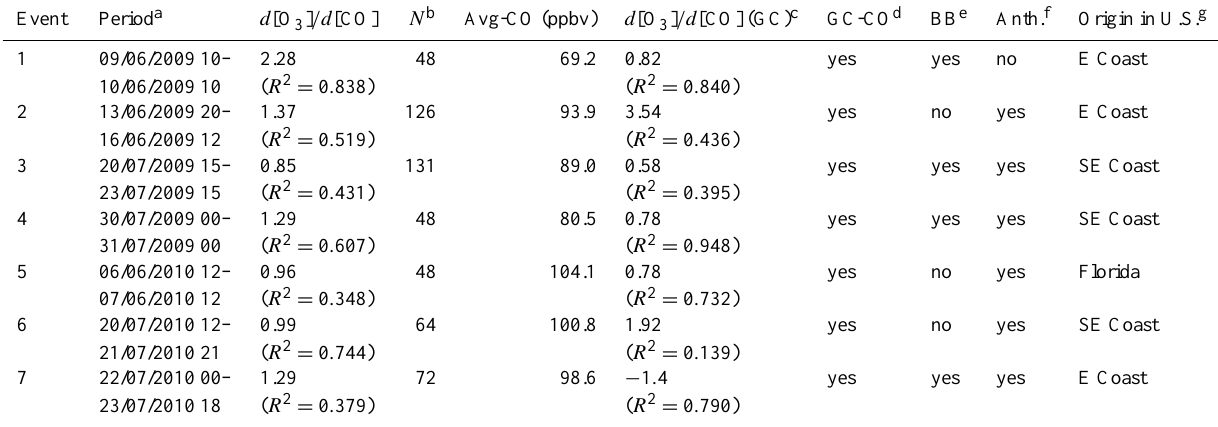
Table 1. Summary of analysis used to identify events resulting from anthropogenic outflows from North America. Event Period a d [O 3 ] /d [CO] N b Avg-CO (ppbv) d [O 3 ] /d [CO] (GC) c GC-CO d BB e Anth. f Origin in U.S.